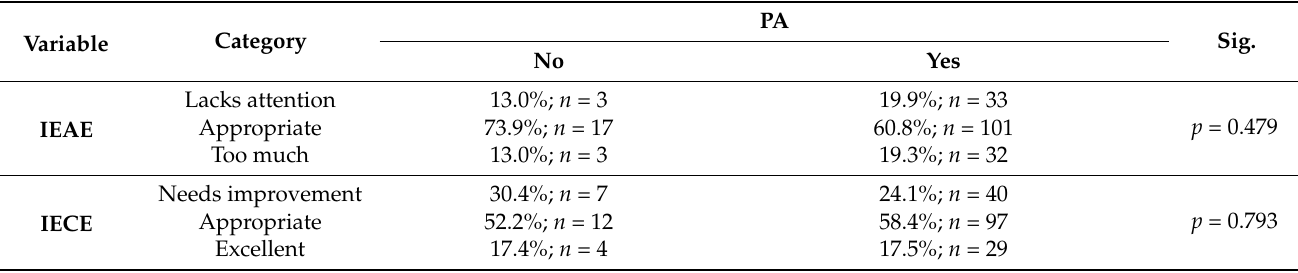
Table 6. Relational study pertaining to the variable of physical activity